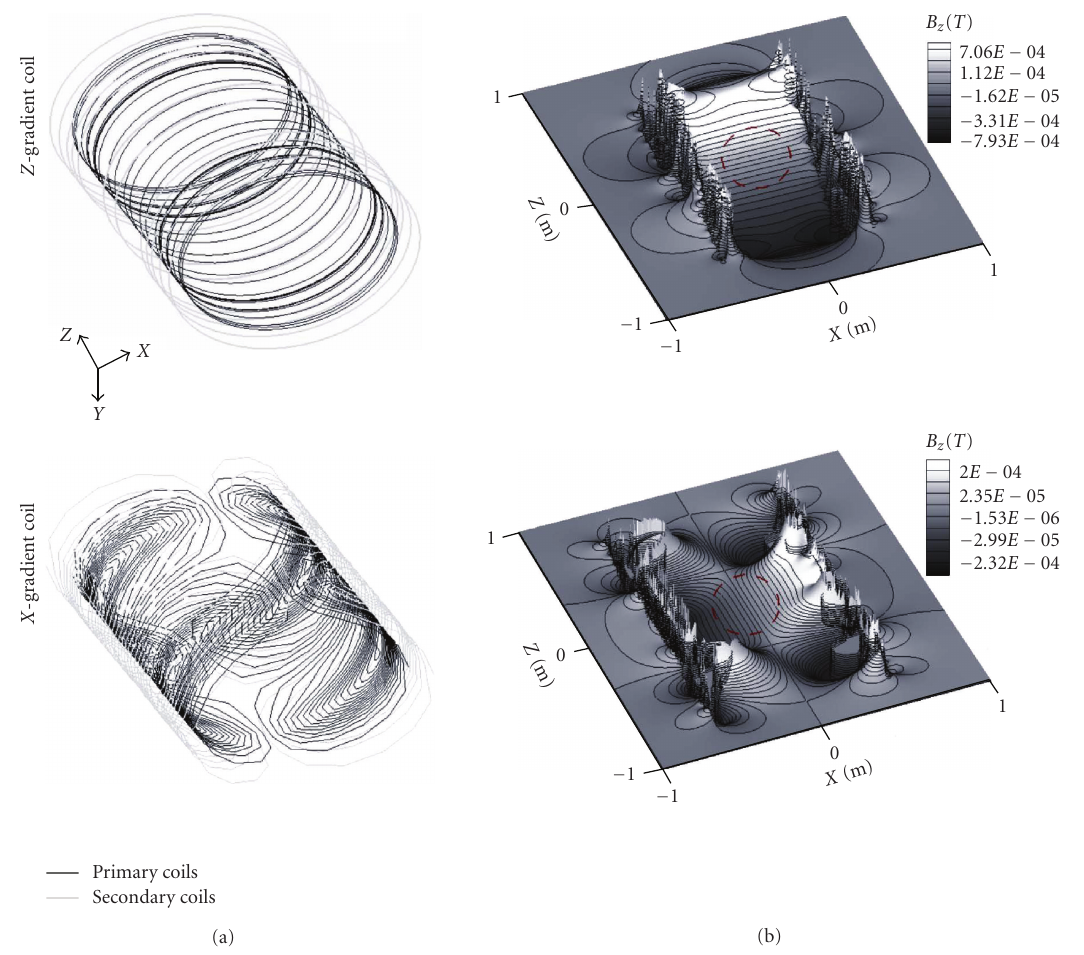
Figure 3: (a) Three-dimensional plot of transverse and longitudinal gradient coil geometry (the primary and secondary windings are indicated in black and grey, resp.) and (b) corresponding spatial gradients of B z . DSV is the diameter spherical volume.